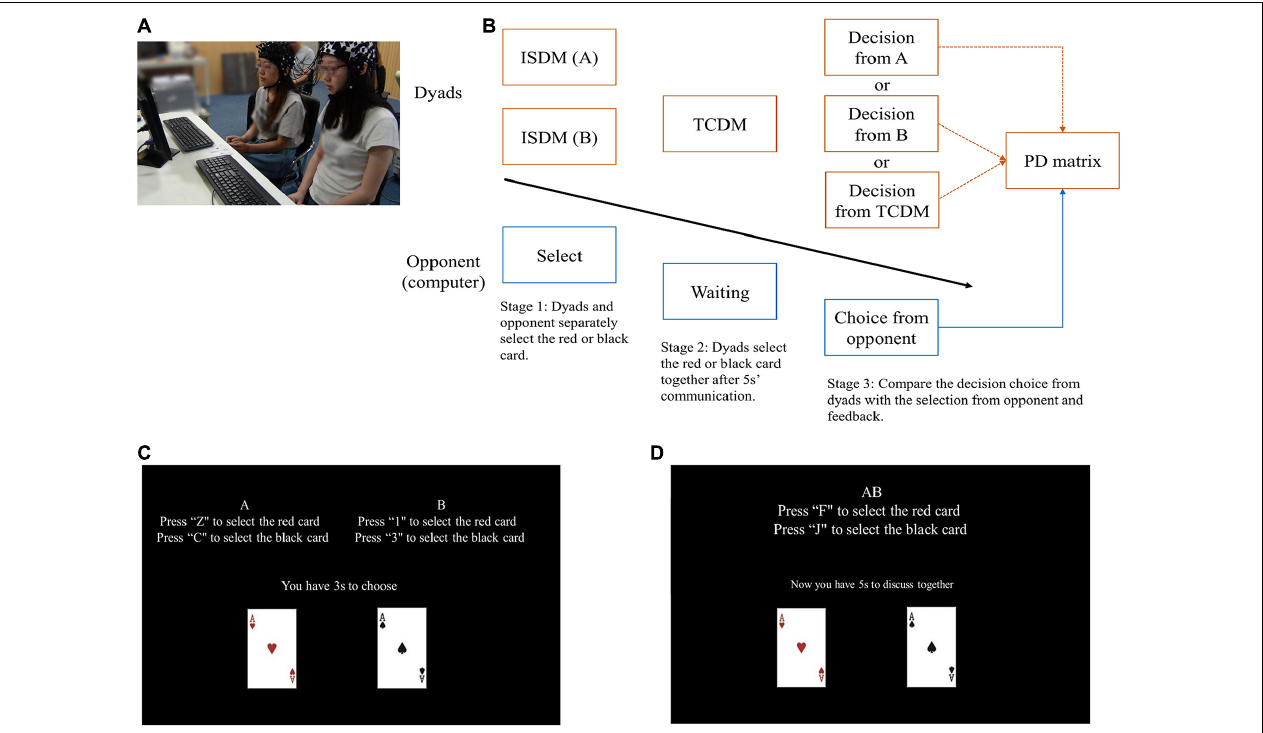
FIGURE 1 | (A) Experimental condition. Two participants sitting side by side act as cooperators playing a computer based PDG. (B) Main experimental procedure. The orange boxes represent the actions of dyads while the blue boxes represent the actions of the computer. The three orange arrows mean the E-Prime program will choose a choice scheme randomly from choice A, choice B or choice AB to compare with choice C. (C,D) Screenshot of the ISDM and TCDM stage.